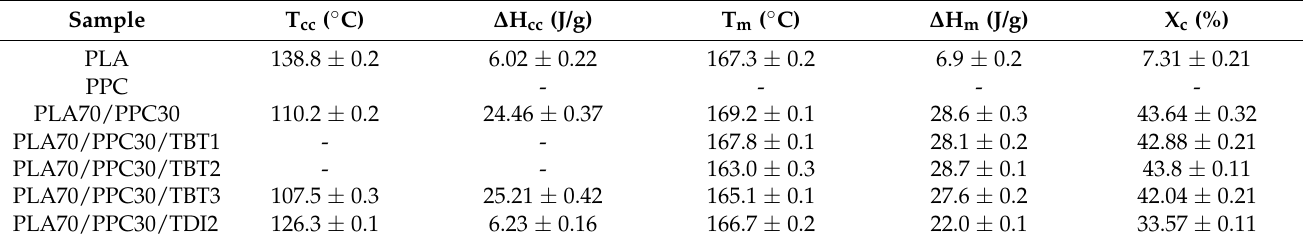
Table 5. Cold crystallization temperature, cold crystallization enthalpy and melt enthalpy of the PLA/PPC blends during a reheating process at 10 ◦